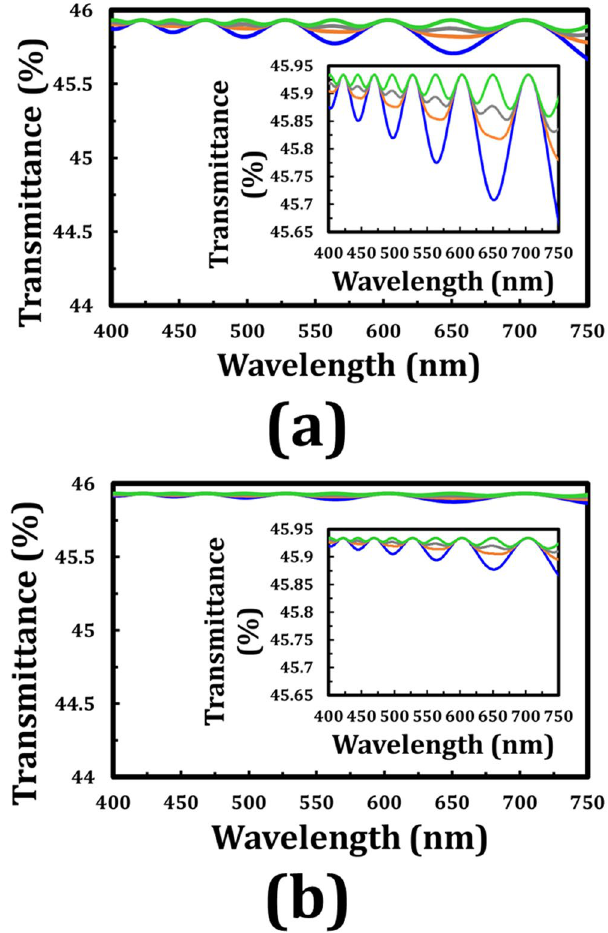
Figure 6. Simulated transmittance (1D-DIMOS) of the output beam through a tandem-2 φ -TNLC cell and an analyzer with its transmissive axis of 2 φ with respect to that of the polarizer ( β ) versus the wavelength of the input beam at different β angles with φ of ( a ) 45° and ( b ) 22.5°. Blue, orange, gray, and green curves represent the different β angles of 0°, 22.5°, 30°, and 45°, respectively. Insets clearly show the details of the spectra.